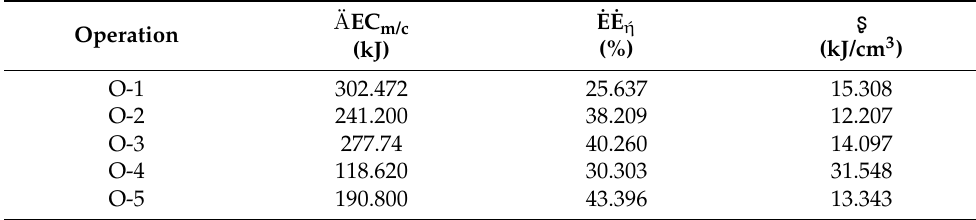
Table 7. Calculations of actual cut during O-1 to